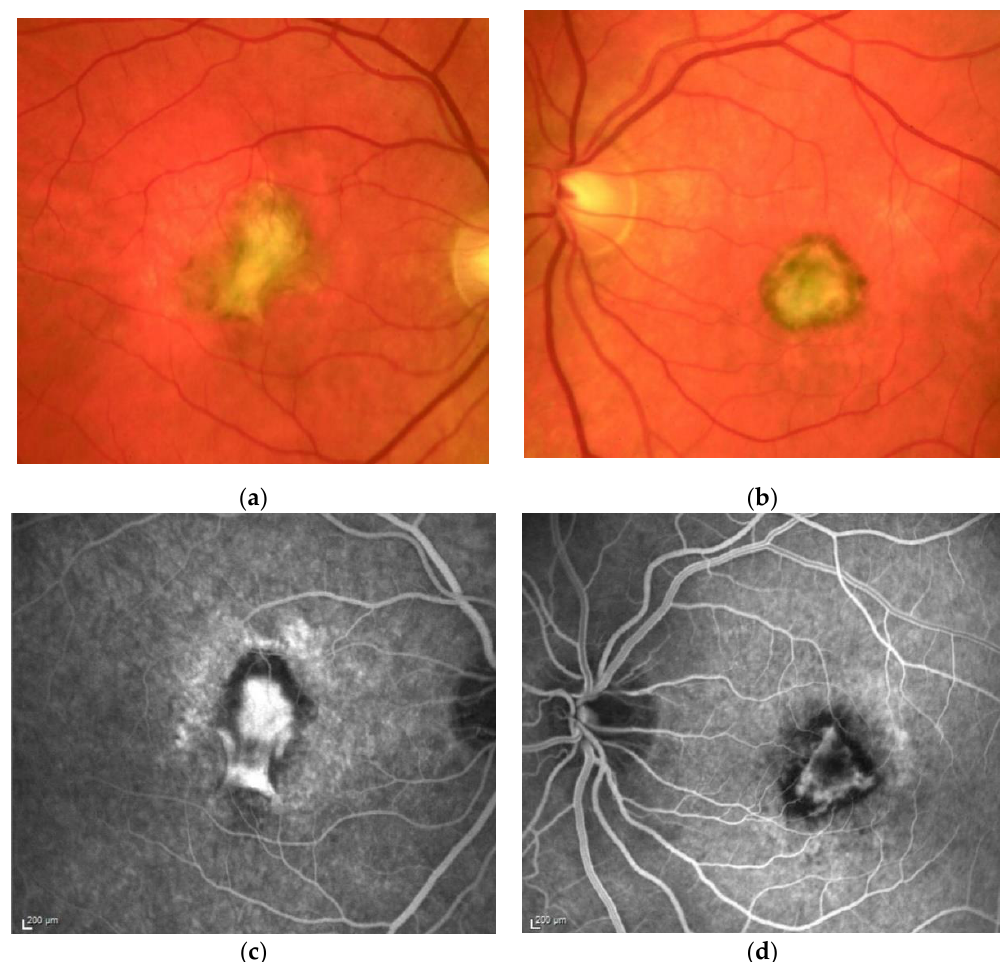
Figure 1. M, 35 years, M. Sorsby. Clinical image of both eyes with a significant submacular fibrovascular lesion after three courses of photodynamic therapy in the right ( a ) and four in the left eye ( b ), prior to the start of intravitreal therapy. (second panel). Same patient, fluorescein angiography (R middle ( c ), L early arteriovenous phase ( d )) confirming a low-active predominantly classic macular neovascularisation.